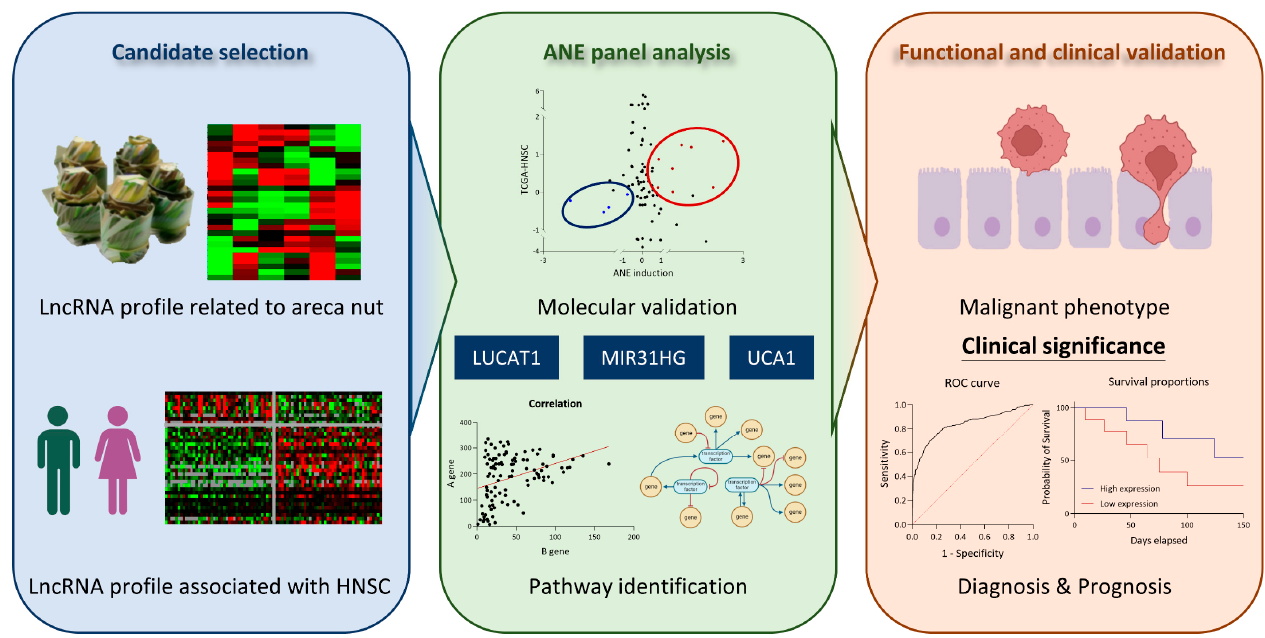
Figure 7. A model of ANE profiling contributes to cell invasion and poor prognosis in HNC.